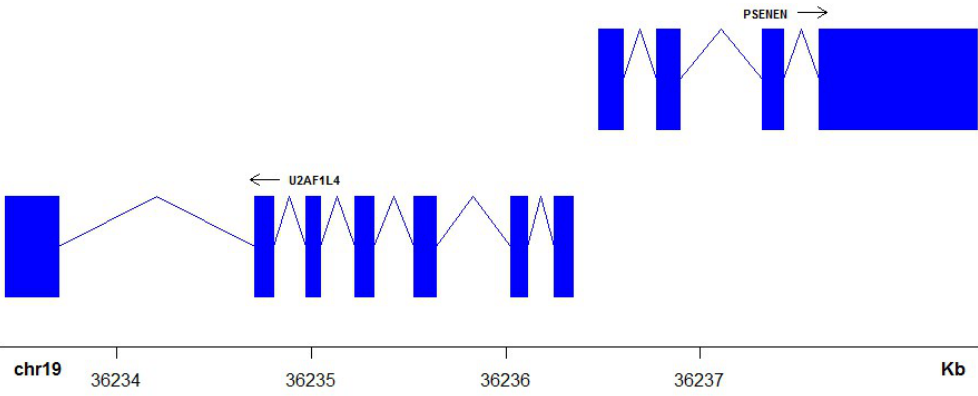
Figure 1. Bidirectional promoter arrangement of PSENEN and U2AF1L4 on chromosome 19. This gene pair has a validated bidirectional promoter that coordinates the expression of these two genes. Arrows indicate direction of transcription, blue boxes indicate exons, and physical position on chromosome 19 is shown in kilobases (Kb).